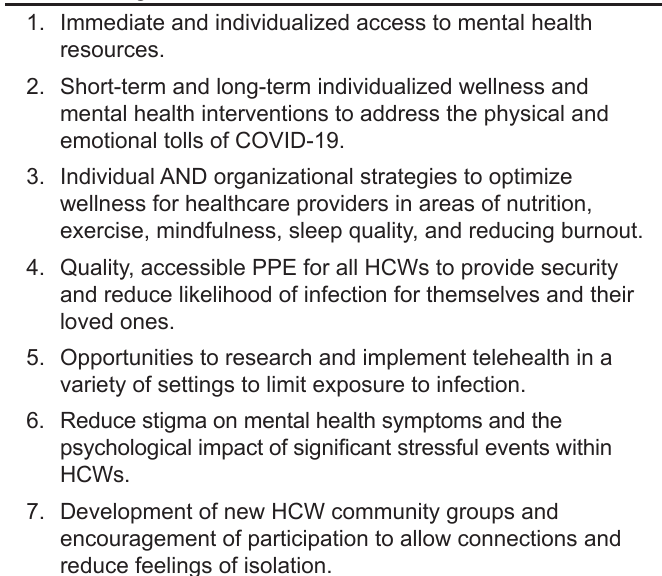
Table. Strategies for healthcare worker wellness.